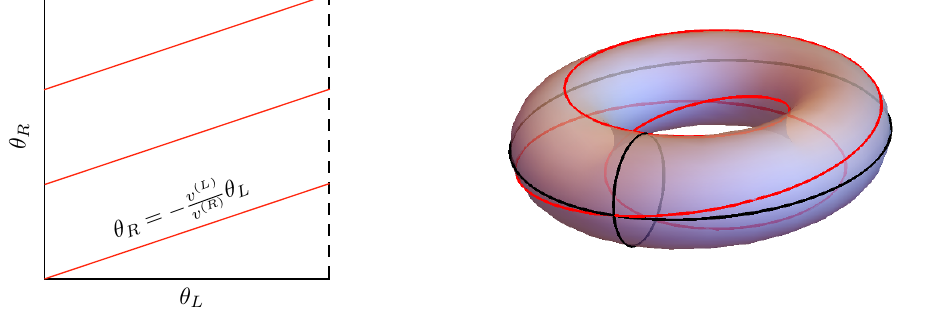
3 m . Note that the value of m is irrelevant for (cid:0)